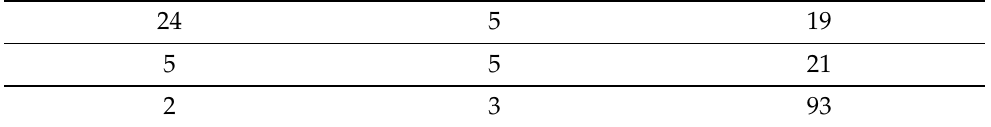
Table 11. Confusion matrix for Glove embedding with the RFE (RF) feature selection method; 150 features.